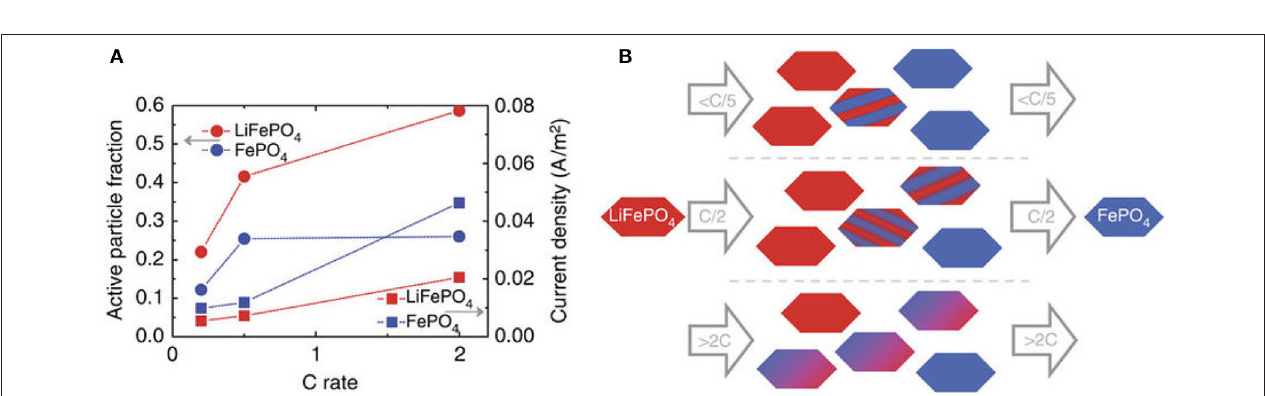
FIGURE 8 | (A) Active fraction and current density of the particles resulting from the average transformation times. (B) : Sketch of the rate-dependent transformation upon charge as follows from the microbeam diffraction experiments (similar upon discharge only with a smaller active particle fraction, see A ). This figure is reproduced from (Zhang et al., 2015) and licensed by